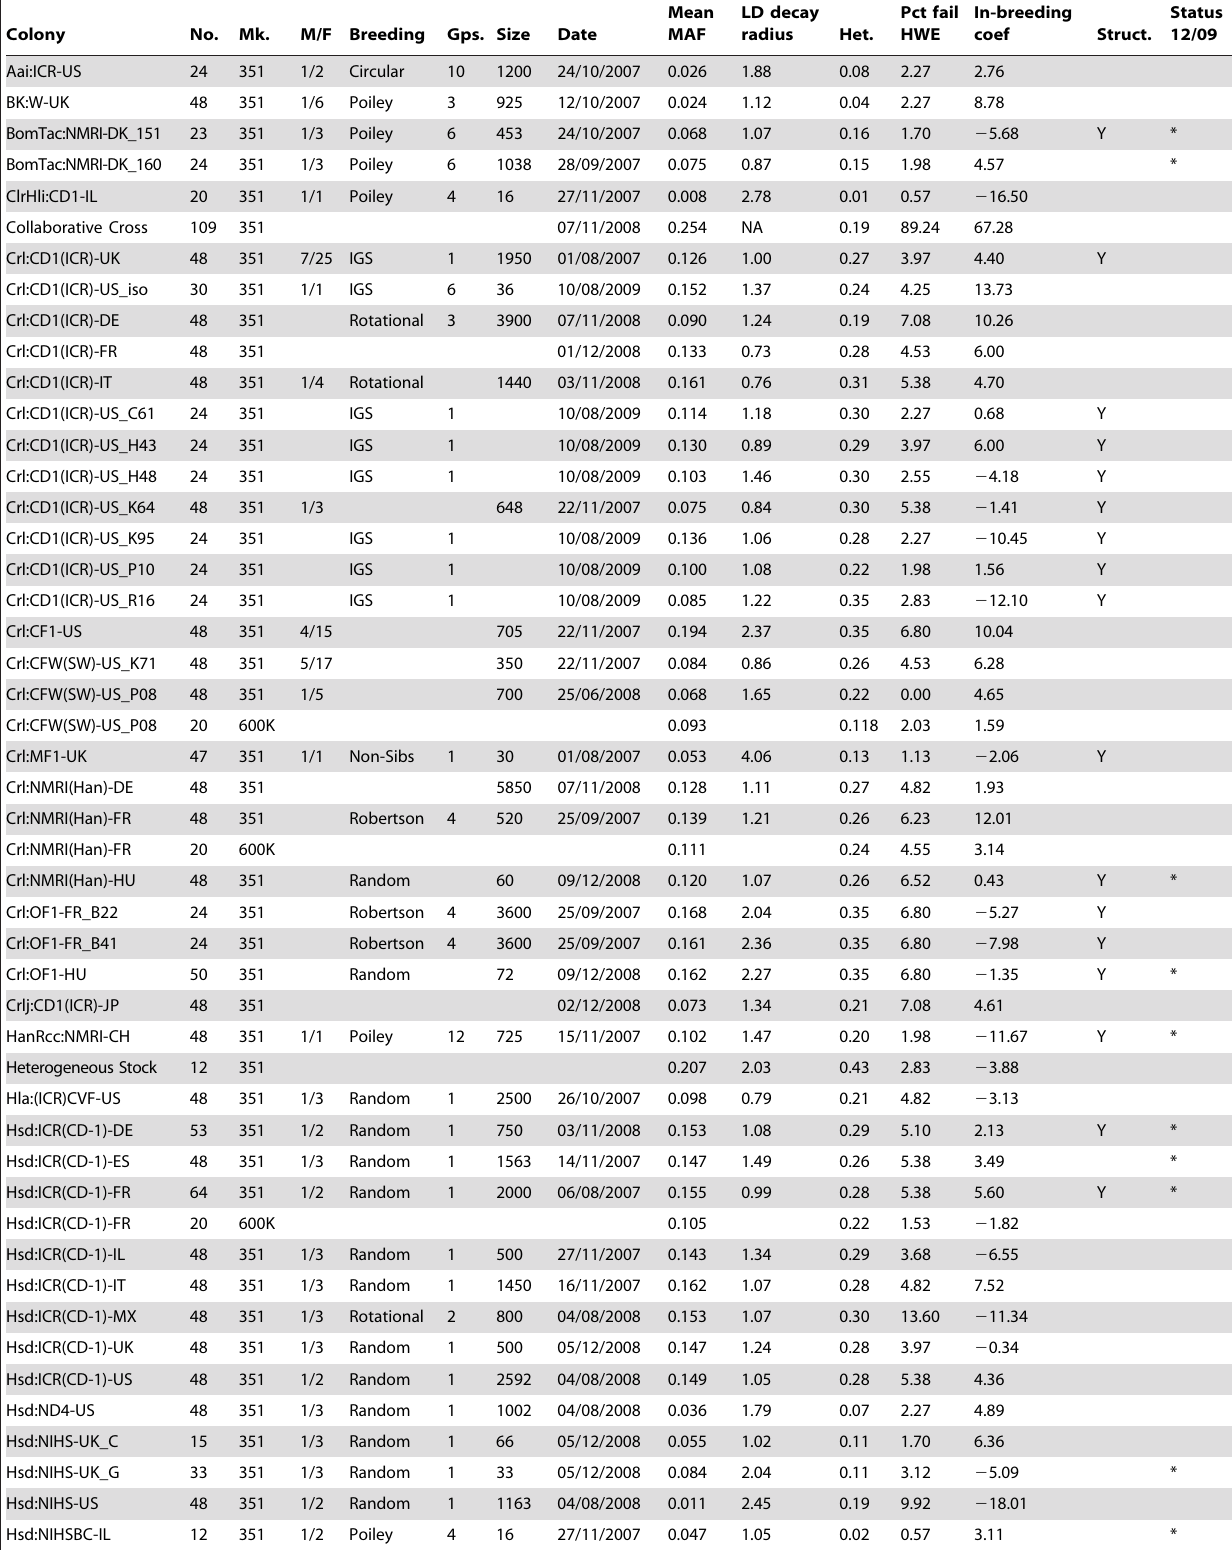
Mean LD decay MAF radius